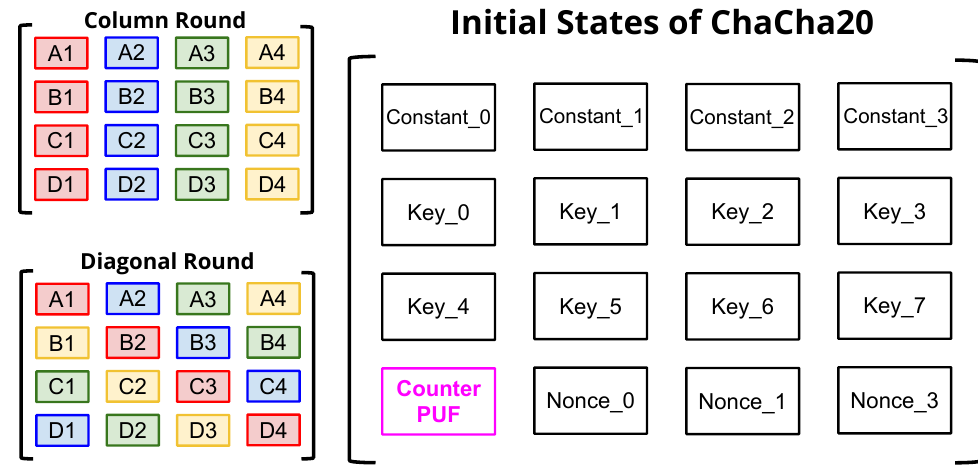
Figure 11. Structure of the column and diagonal rounds, along with the initial states of the PUF- ChaCha20